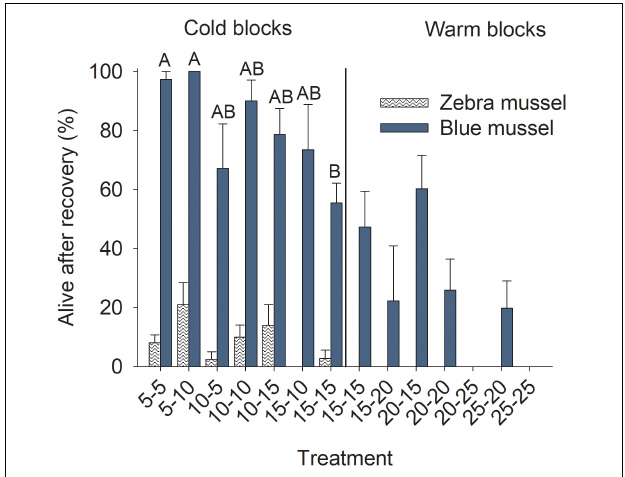
FIGURE 8 | Proportion of marine blue mussels ( Mytilus edulis ) and freshwater zebra mussels ( Dreissena polymorpha ) still alive after 5 days of the recovery phase. Bars show mean (+SE, n = 4) and columns not sharing a common letter (within a Block and Species combination) are significantly different (Tukey post hoc tests). Vertical lines show the separation between the cold and warm